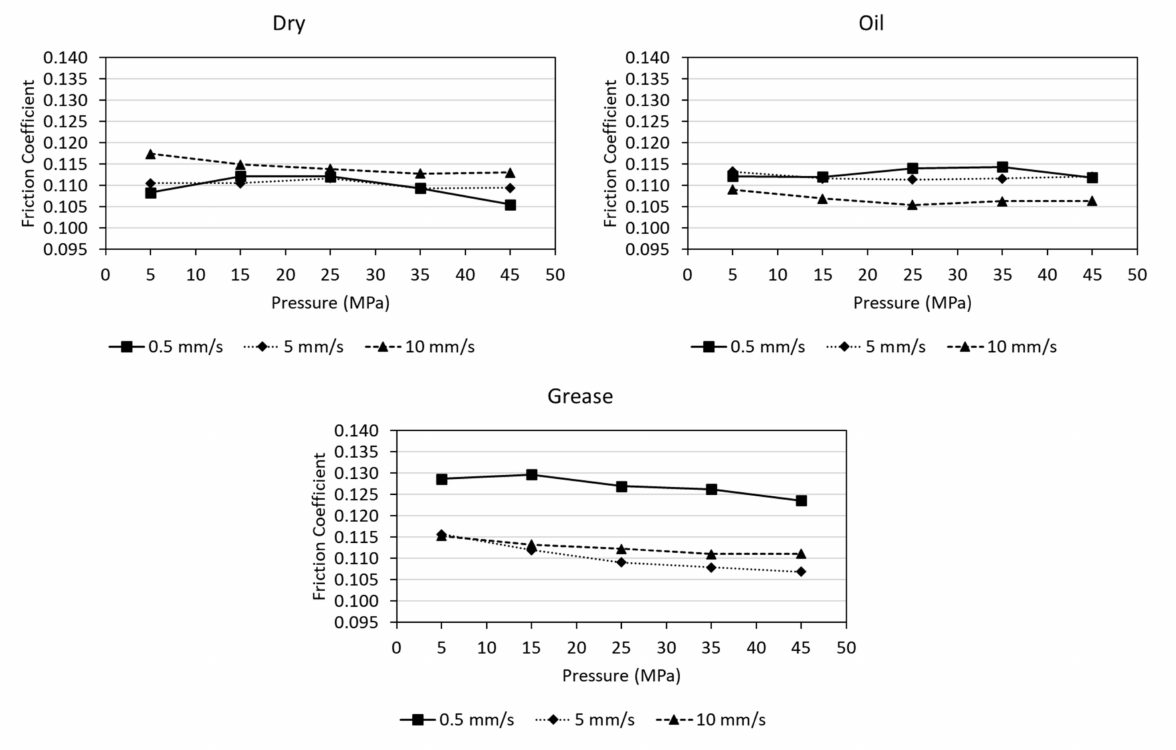
Figure 4. Dependence of average friction coefficients at the speeds of 0.5, 5 and 10 mm/s on pressure at room